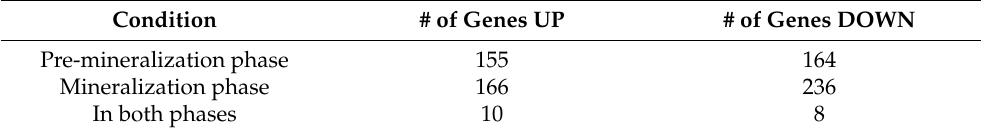
Table 1. Number of transcripts on average that are 2-fold up- or downregulated in the pre- mineralization or mineralization phase of human osteoblasts *.